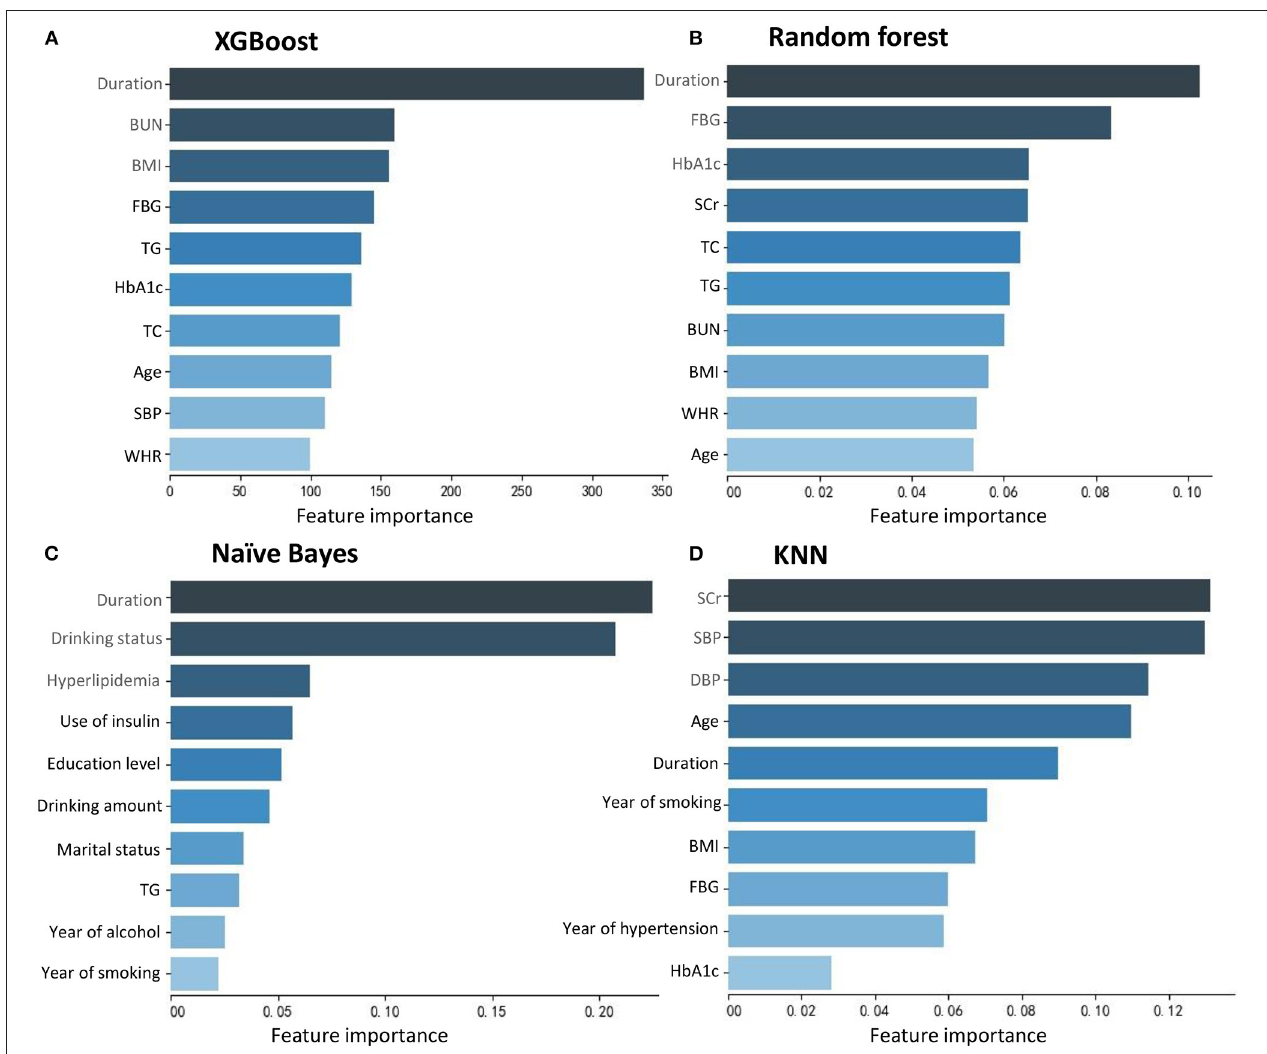
FIGURE 2 | Feature importance contributed to each machine learning model. (A) XGBoost. (B) Random forest. (C) Naïve Bayes. (D) KNN.